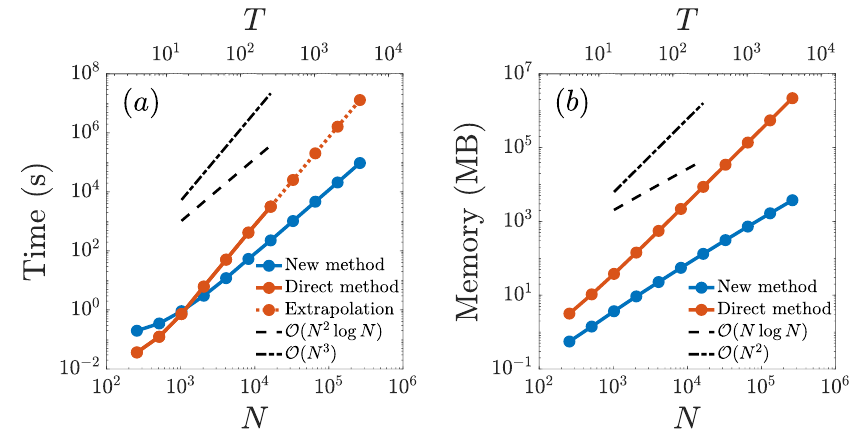
Figure 1: (a) Wall clock time and (b) memory used by the direct method and our method for the Falicov-Kimball model with a rapid ramp of the interaction parameter, showing the improved scalings. The time step ∆ t is fixed, and the number of time steps is increased from N = 256 to 262144, corresponding to an increase of the propagation time from T = 4 to 4096. The direct method is impractical for large N , so we show extrapolated